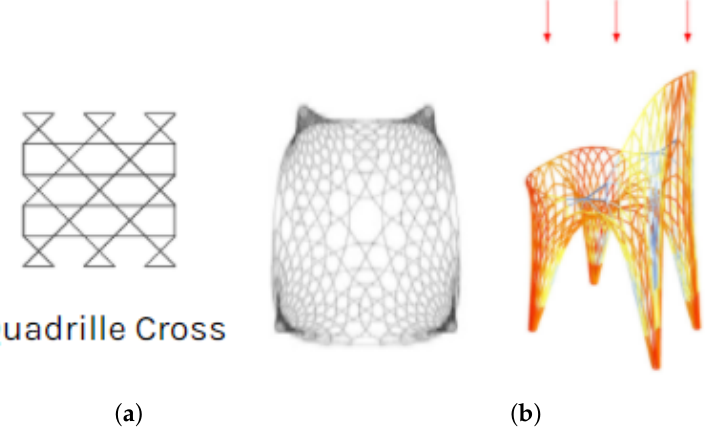
Figure 9. Applied patterning ( a ) Various patterns applied to the chair shown in plan view and isometric. ( b ) Simulated structural tests in digital